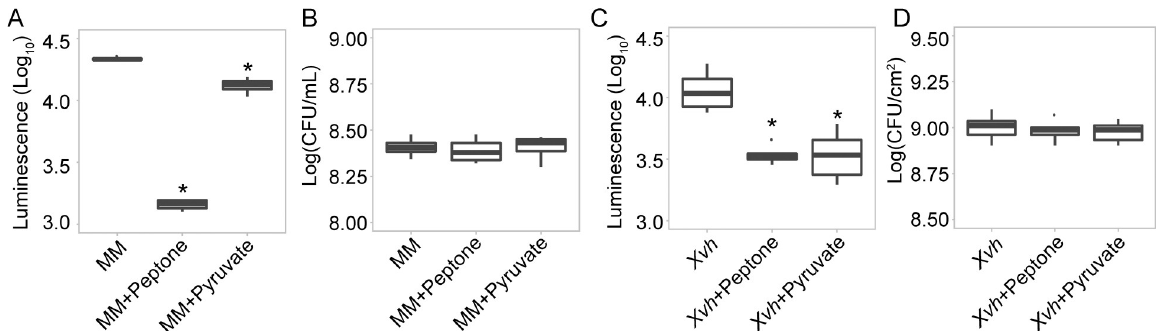
Fig 12. Impacts of nutrients on the expression of T3SS-associated genes of Xvh in vitro and in planta . (A-B) Xvh expressing hrpF fused to a luciferase (Luc) reporter [ Xvh ( hrpF _promoter_ Luc )] grows in T3SS/T3E-inducible minimal media (MM) in absence or presence of peptone (2%) and pyruvate (20 mM), respectively. Bacteria were cultured for 12 hours and then adjusted to OD 600nm = 0.6 for assaying luciferase activity (A). (B) Bacterial populations (OD 600nm = 0.6) were determined and are shown as colony-forming units (CFU). Mean ± s.d.; n = 4 biological replicates. Asterisks indicate statistical significance based on unequal variances t test (n = 4, � p < 0.05) comparison with MM treatment. (C-D) Sorghum NTJ2 leaves were infected with Xvh ( hrpF _promoter_ Luc ) (OD 600nm = 0.5 (~1 × 10 9 cfu/mL)) in the absence or presence of the indicated nutrients. Luciferase activity assay was performed at 48 hpi (C). Peptone and pyruvate were used at 0.5% (w/v) and 20 mM, respectively. (D) Bacterial populations were determined at 48 hpi and are shown as colony-forming units (CFU). Mean ± s.d.; n = 5 biological replicates. Asterisks indicate statistical significance based on unequal variances t test (n = 5, � p < 0.05) comparison with Xvh infection.